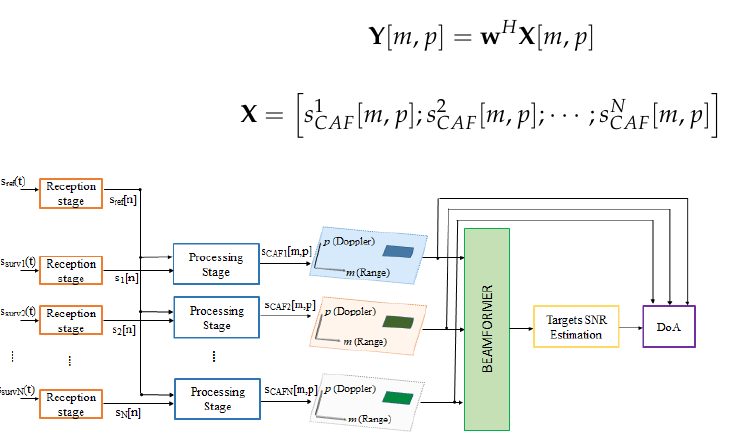
Figure 4. Scheme of processing stages employed showing beamforming processing in range- Doppler